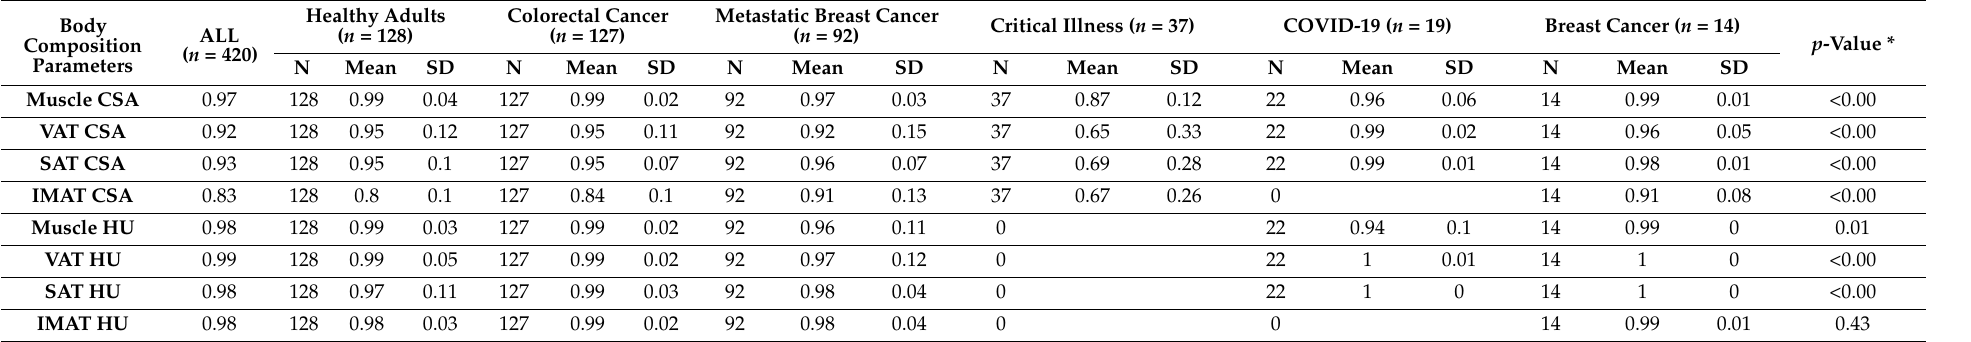
Table 4. Dice similarity coefficient estimates across